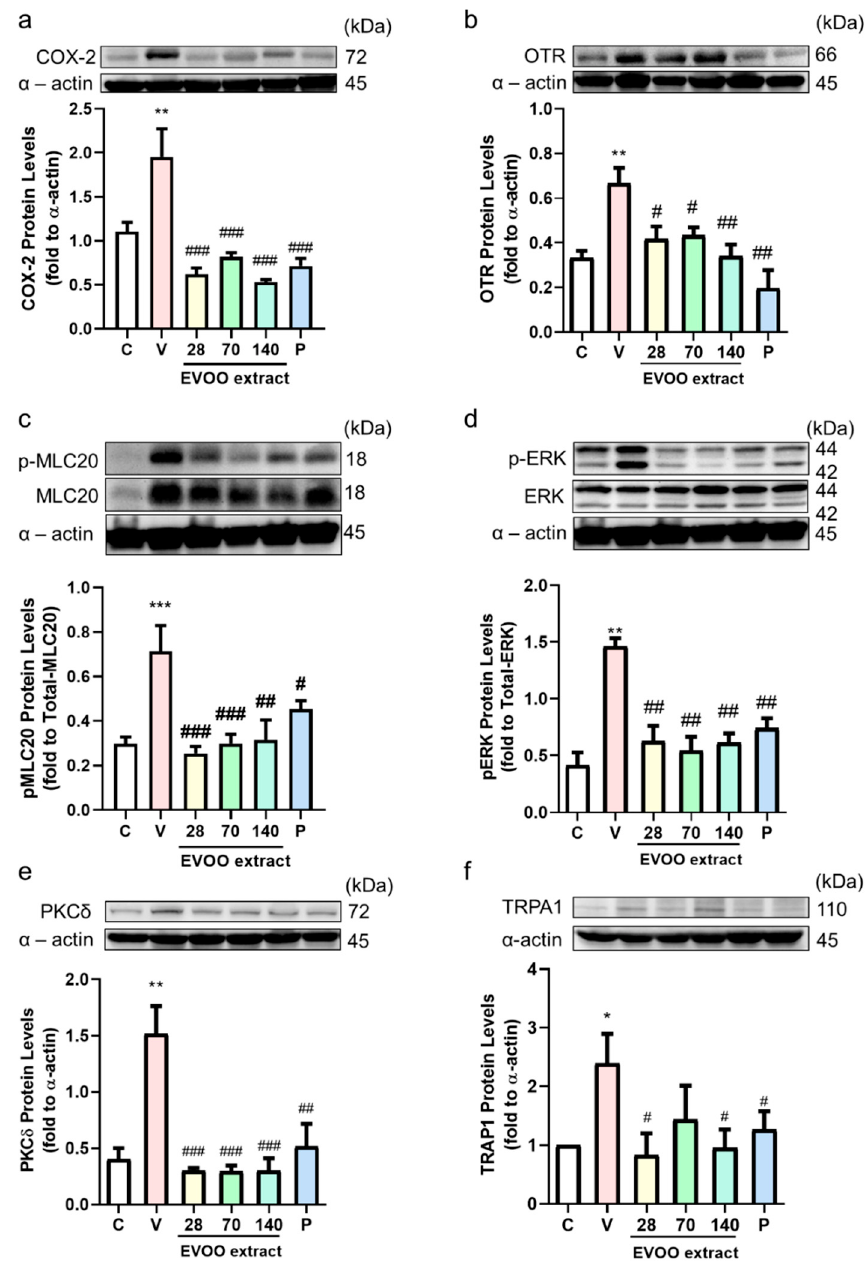
Figure 6. Extra virgin olive oil (EVOO) extracts modulated uterine contraction-related protein expression. Mice were treated with EVOO extracts (28, 70, 140 mg/kg oral gavage) or the same volume of vehicle or ibuprofen each week before oxytocin injection. After 30 min, we collected uterine samples for the Western blot test. ( a ) cyclooxygenase-2 (COX2), ( b ) oxytocin receptor (OTR), ( c ) phosphor–myosin light chain 20 (p-MLC20), ( d ) p-ERK, ( e ) PKC δ , and ( f ) Transient receptor potential ankyrin 1 (TRPA1) protein expression. C, control; V, vehicle (oxytocin-induced) P, ibuprofen 120 mg/kg. * p < 0.05; ** p < 0.01; *** p < 0.001 compared with C group. # p < 0.05; ## p < 0.01; ### p < 0.001 compared with V group. OTR: ERK: extracellular signal-regulated kinase, MLC20: myosin light chain 20, PKC δ : protein kinase C- δ ,